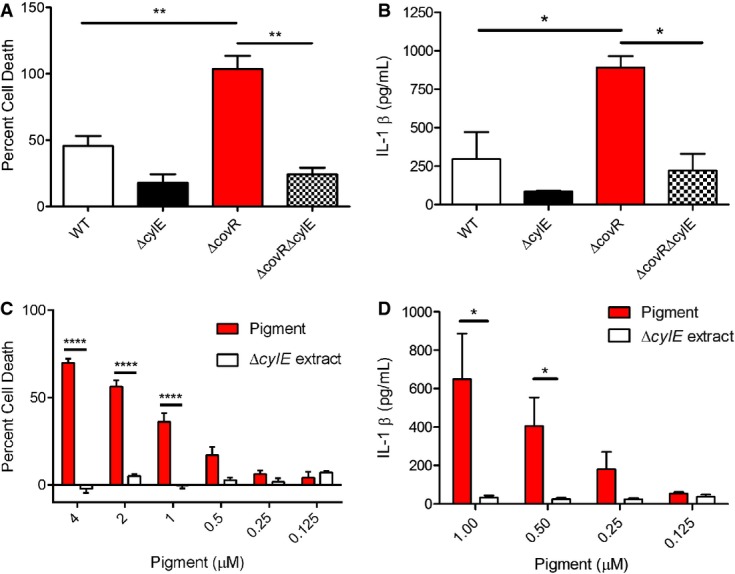
The GBS pigment toxin/lipid toxin is pro-inflammatory and cytotoxic to immortalized THP-1 monocyte-derived macrophages
A, B WT THP-1 macrophages were treated with GBS WT, ΔcylE, ΔcovR, or ΔcovRΔcylE at an MOI of 1 and incubated for 4 h. Cytotoxicity was measured by LDH release (A), and IL1β release in supernatants was measured by Luminex assay (B).

C, D WT THP-1 macrophages were incubated with various concentrations of GBS pigment or control ΔcylE extract for 4 h. Cytotoxicity was measured by alamar blue assay (C), and IL1β release from pigment- or ΔcylE extract-treated cells was measured by Luminex assay (D).Data information: Data from three independent experiments performed in triplicate are shown, error bars ± SEM. Significance was determined using Bonferroni's multiple comparison test following ANOVA. (A) n = 3, **P = 0.0080 for WT versus ΔcovR; **P = 0.0016 for ΔcovR versus ΔcovRΔcylE. (B) n = 3, *P = 0.03 for WT versus ΔcovR; *P = 0.02 for ΔcovR versus ΔcovRΔcylE. (C) n = 3, ****P < 0.0001. (D) n = 3, *P = 0.01.